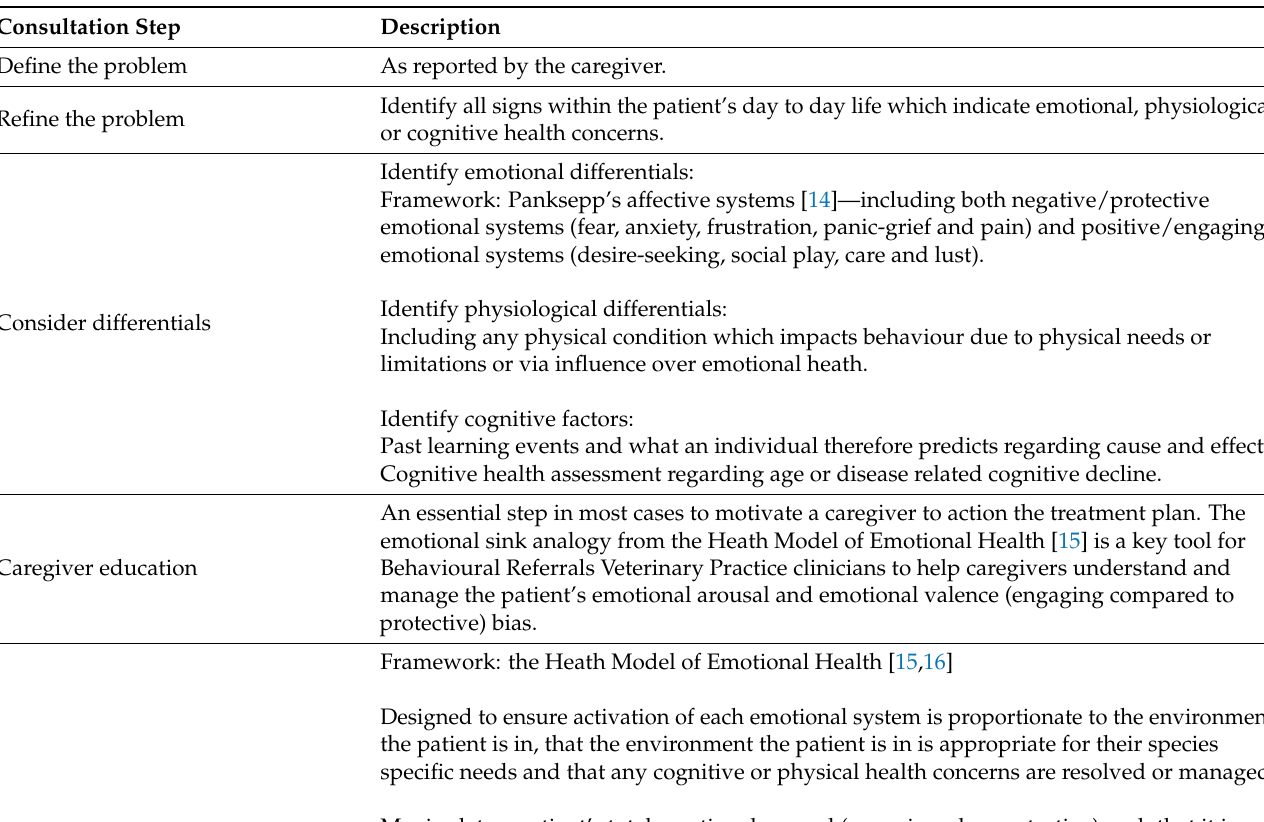
Table 1. A guide to the steps involved in a behavioural medicine case